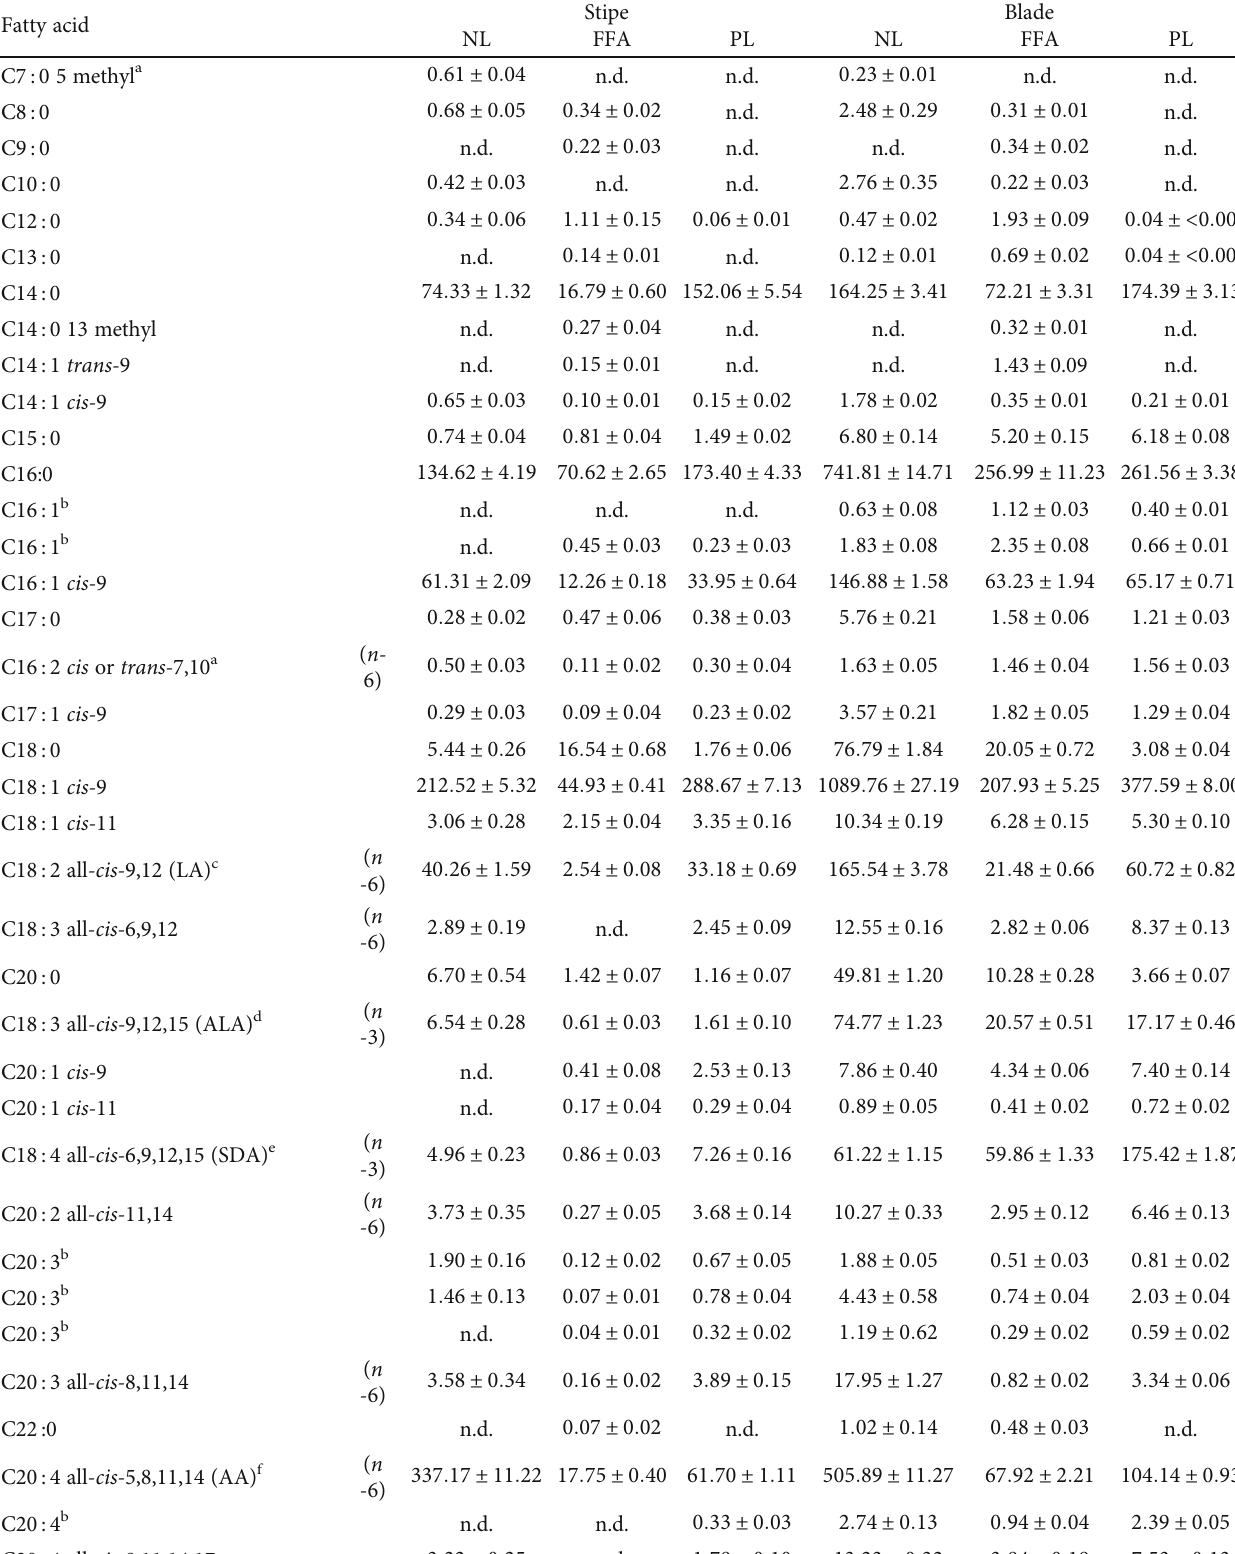
Table 1: Fatty acid content in the lipid fractions ( mean ± SD , μ g/g DW) of stipe and blade from L. hyperborea ( n = 4 , two injection parallels for each of these four sampling